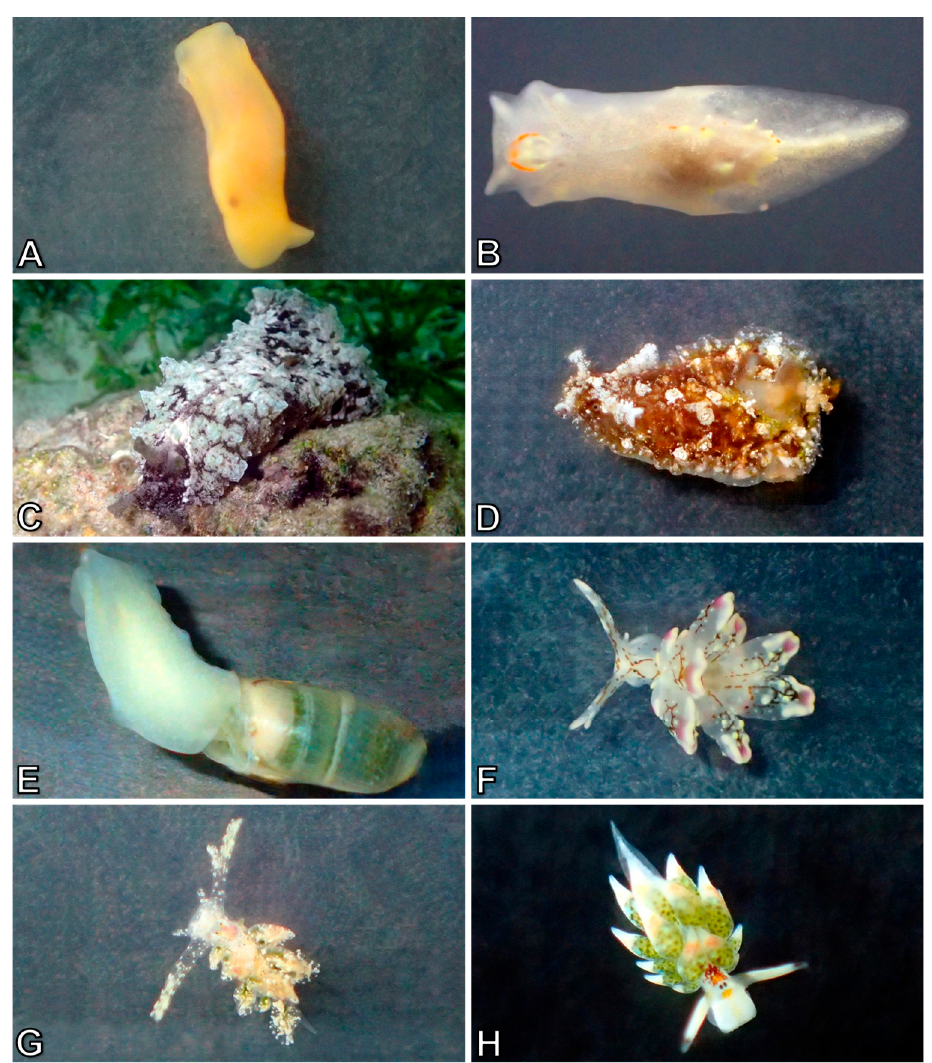
Figure 17. Cephalaspidea, Anaspidea and Sacoglossa: ( A ) Philine spec., Ilsp17Bu-1; ( B ) Sagaminopteron spec.; ( C ) Dolabella auricularia ; ( D ) Dolabrifera dolabrifera ; ( E ) Cylindrobulla spec., Assp1_17Bu-2; ( F ) Cyerce cf. bourbonica ; ( G ) Sohgenia palauensis ; ( H ) Costasiella kuroshimae.